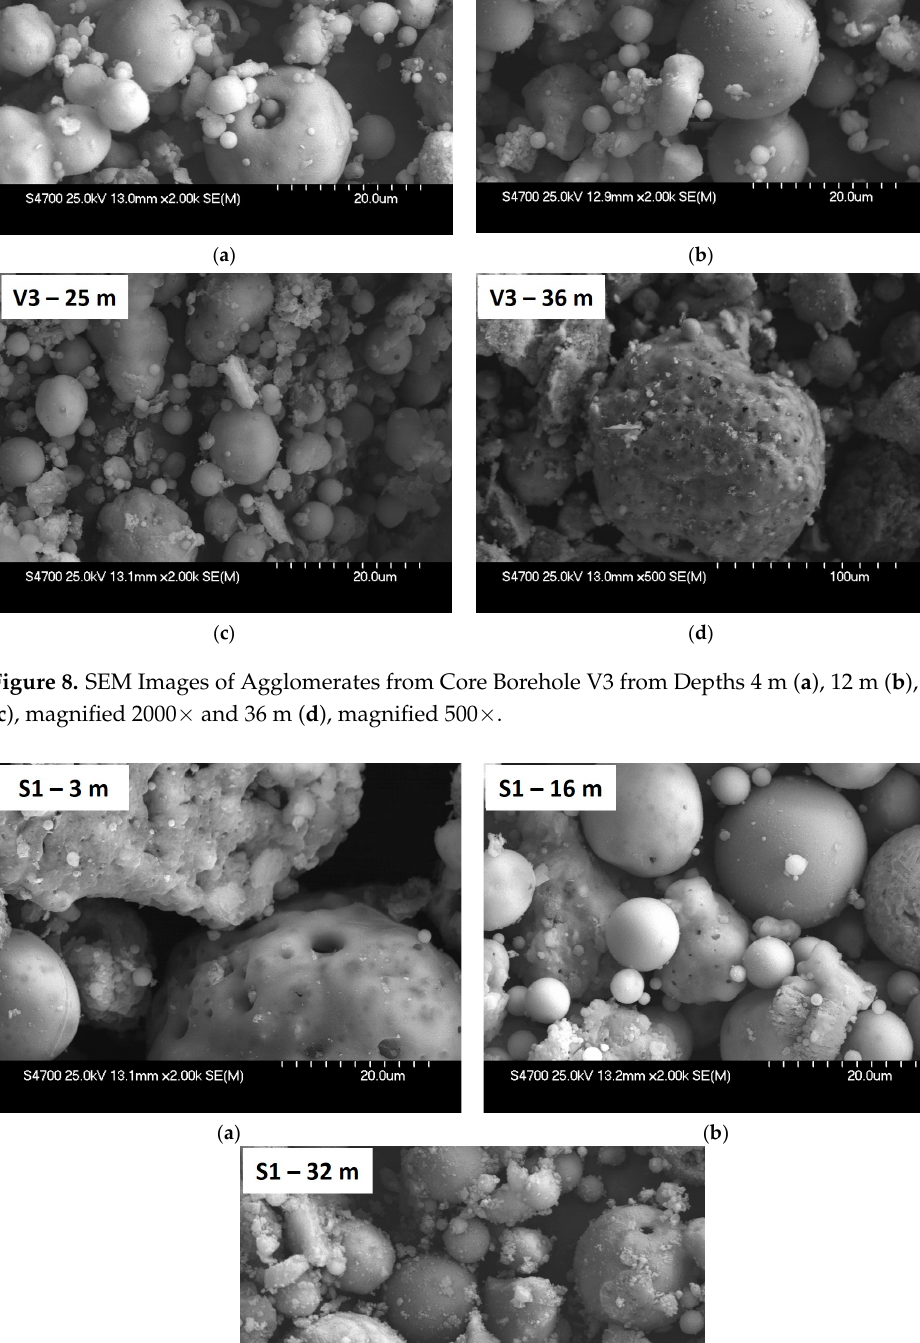
Figure 9. SEM Images of Deposited S1 Bottom Ash from Core Borehole Depths of 3 m ( a ), 16 m ( b ) and 32 m ( c ), magnified 2000 ×